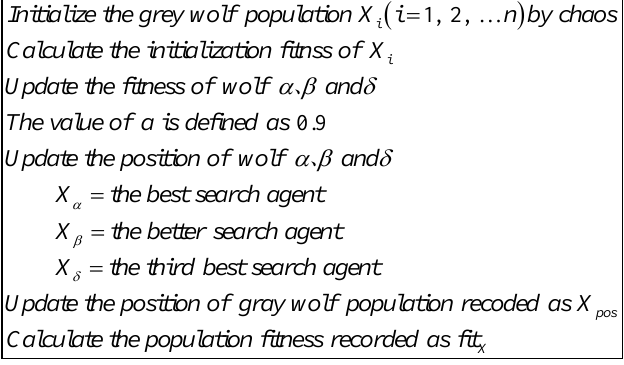
Figure 2. The pseudo code of the SiGWO algorithm.